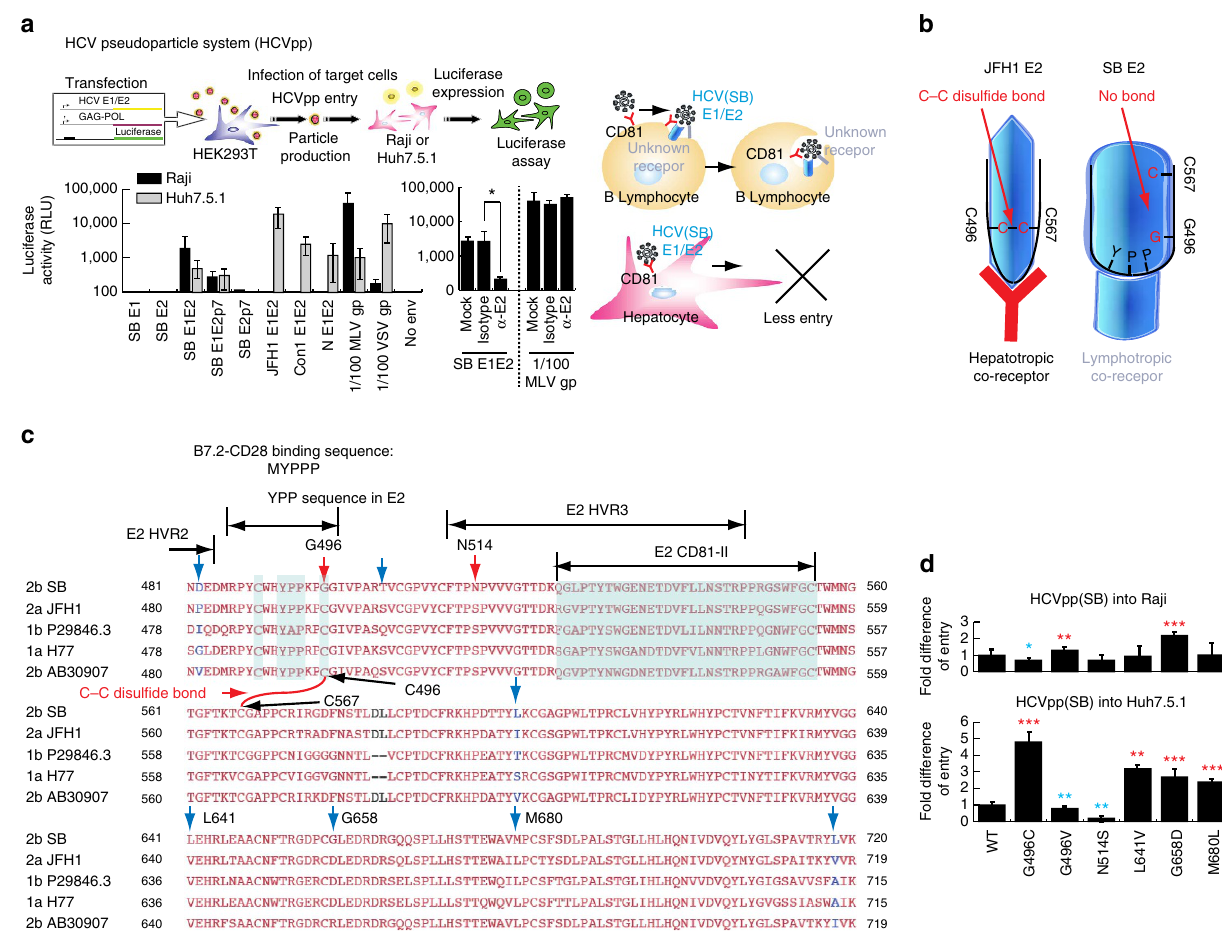
Figure 2 | Lymphotropic pseudoparticles (HCVpp) can infect B lymphocytes more efficiently than hepatic cells. ( a ) HIV-luc vector was pseudotyped with envelope proteins of HCV SB strain. Pseudoparticles (HCVpp) efficiently infected B lymphocytes, but not hepatic cells. Infectivity of HCV pseudo-particles was measured by luciferase assay. HIV vector containing a luciferase reporter pseudotyped with E1 and/or E2 of SB strain, Con1, or HCV-N strain and MLVglycoprotein (MLVgp), or no envelope (no env) was used to infect Raji (black bars) or Huh7.5.1 (grey bars). Luciferase activity was assayed at 4 days after infection. Addition of neutralizing anti-E2 antibody blocked HCVpp entry ( a , right). Experiments were repeated at least three times (* P o 0.05, T -test, n ¼ 3). Error bars represent s.d. ( b ) Hypothetical model of E2 sequence mutations on HCV B cell tropism. ( c ) The HCV E2 amino acids sequences are variable. Red arrows indicate the different amino acid positions between SB and other HCV strains. 1b strain is from sequence accession number P29846.3. ( d ) Variations of E2 sequences change HCV tropism (* P o 0.05; ** P o 0.01; *** P o 0.001, ANOVA, n ¼ 3). Error bars represent